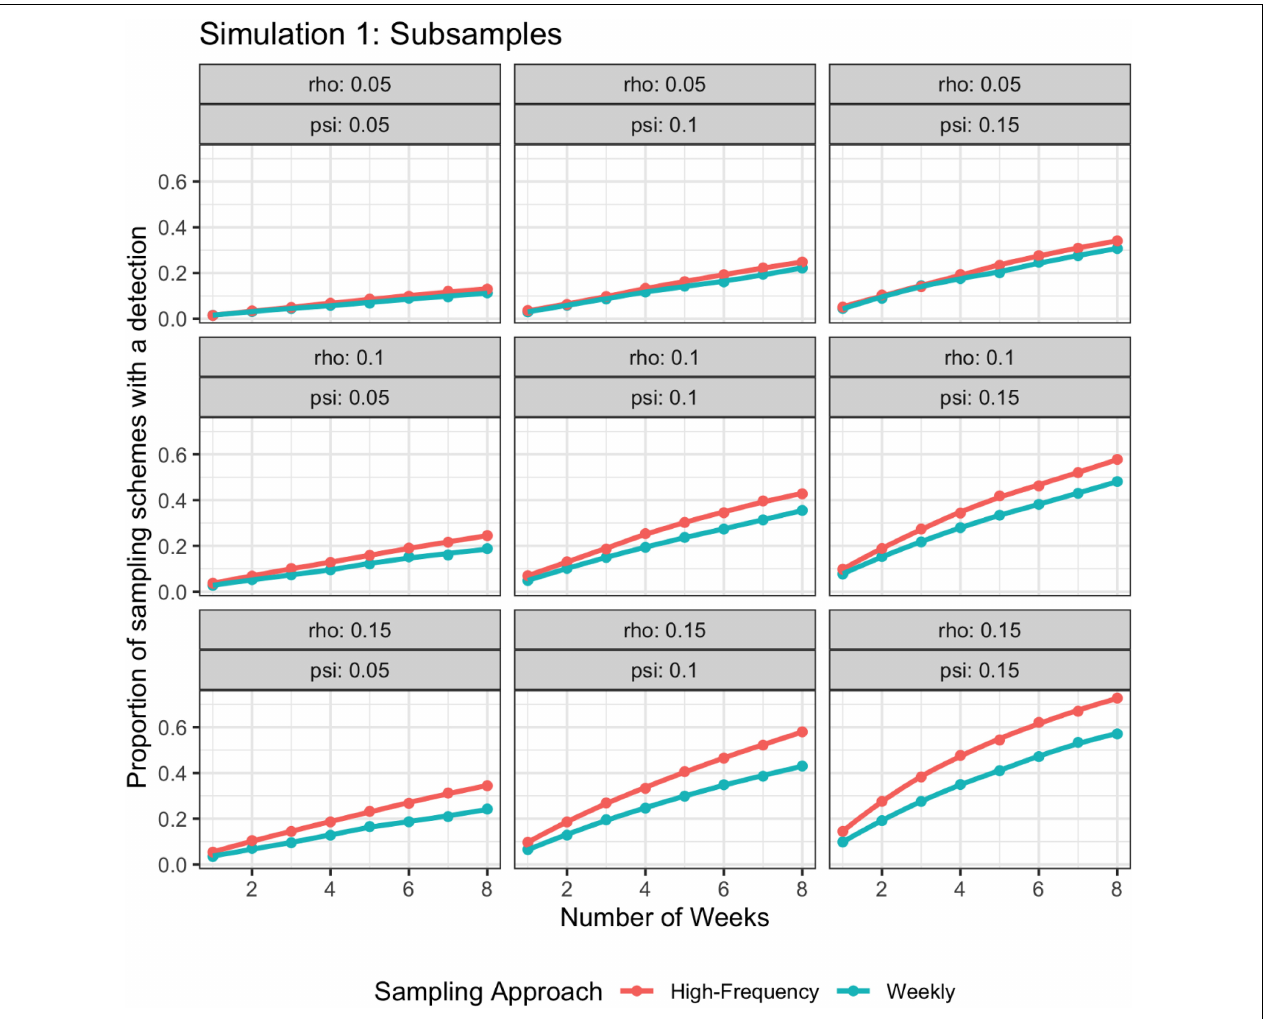
FIGURE 4 | Probability of detection as a function of rho , psi , and number of weeks; rho does not vary by time. The high-frequency approach collects samples daily and the weekly approach takes seven samples once a week. Weekly samples are modeled as non-independent